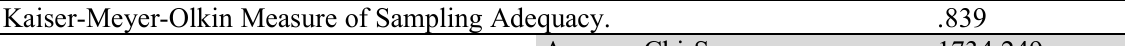
The results of KMO and Bartlett's Test of Sphericity Kaiser-Meyer-Olkin Measure of Sampling Adequacy. .839 Approx. Chi-Square 1734.249 Bartlett's Test of Sphericity